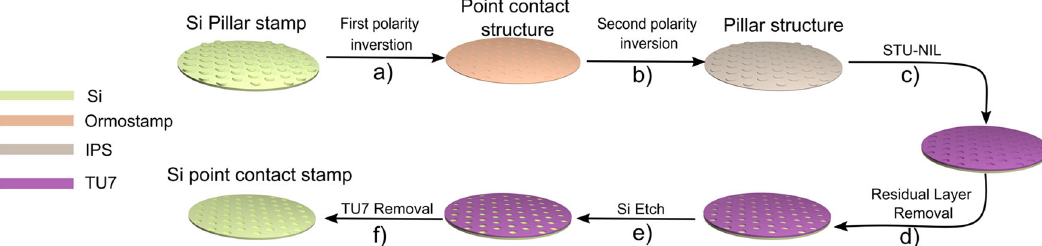
Fig. 8 200 nm point contact stamp replication process. Schematic with the 200 mm point contact Si Stamp fabrication steps. Not at